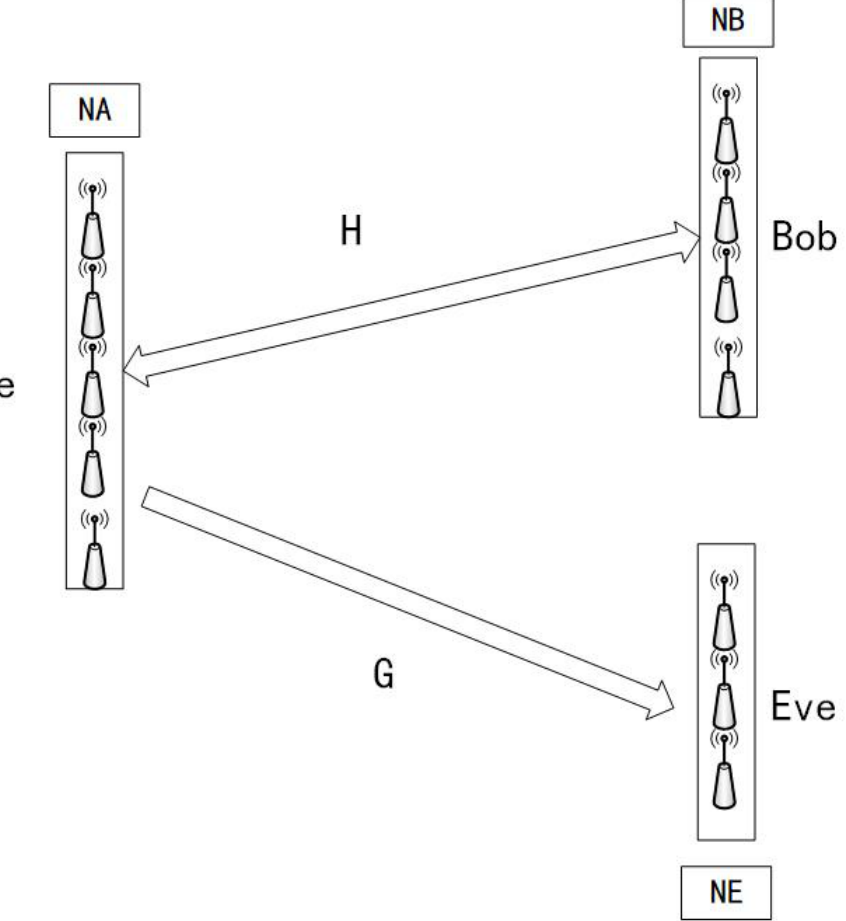
Figure 1. Wireless communication model with